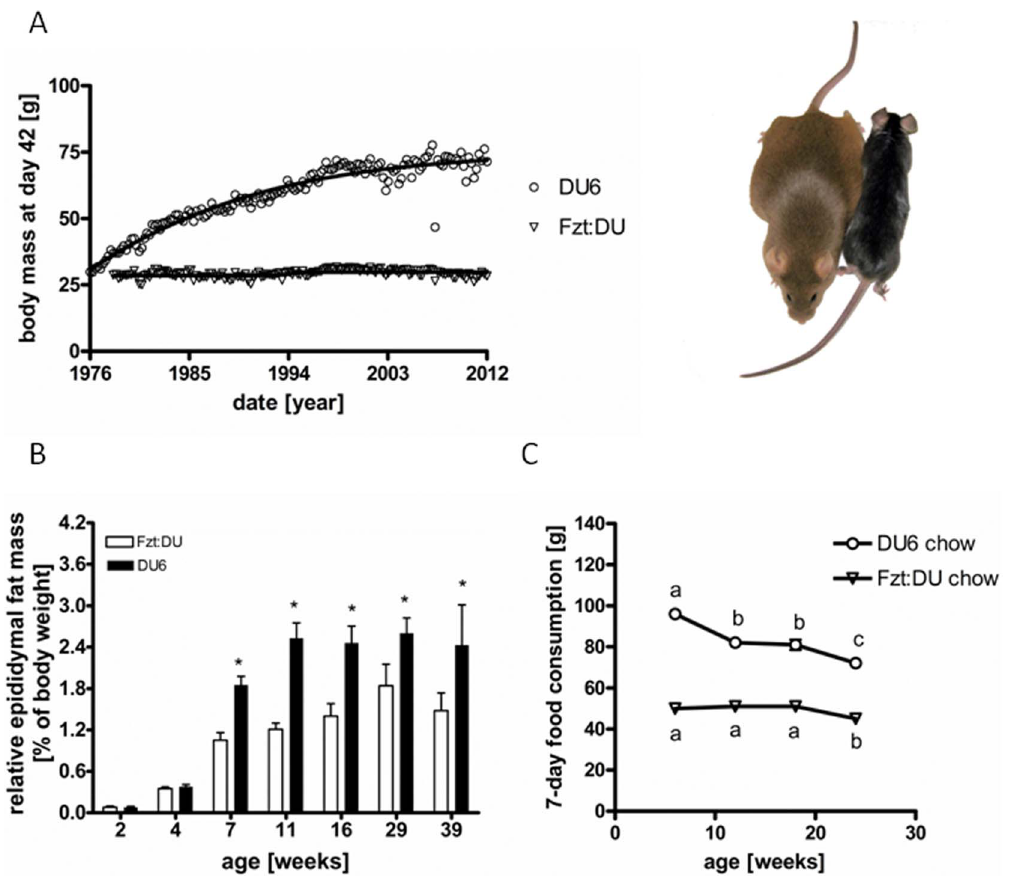
Figure 1. Establishment and basic features of the polygenic DU6 mouse model. Body weight selection was performed over 146 generations beginning in 1976 (Fig 1A). Epididymal fat mass (Fig. 1B) in male DU6 mice from 7 to 39 weeks of age (n=15; *: P , 0.01; in 39-week DU6 mice: n=9). Longitudinal consumption of chow food (Fig 1C) was assessed in male mice in 4 different age groups over a period of 7 days (6, 12, 18 and 24 weeks of age; n . 12; *: P , 0.01).